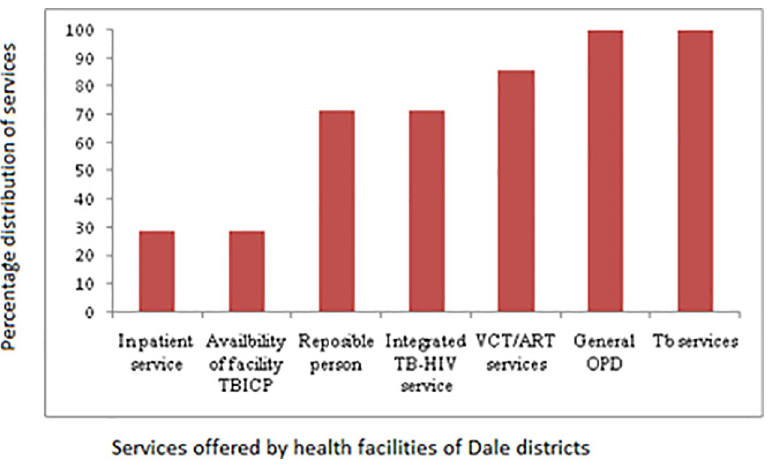
Fig 2. Distribution of TB related services other than TBIC plan and in-patient service in the Dale district health facilities, Sidama Zone, Southern Ethiopia.